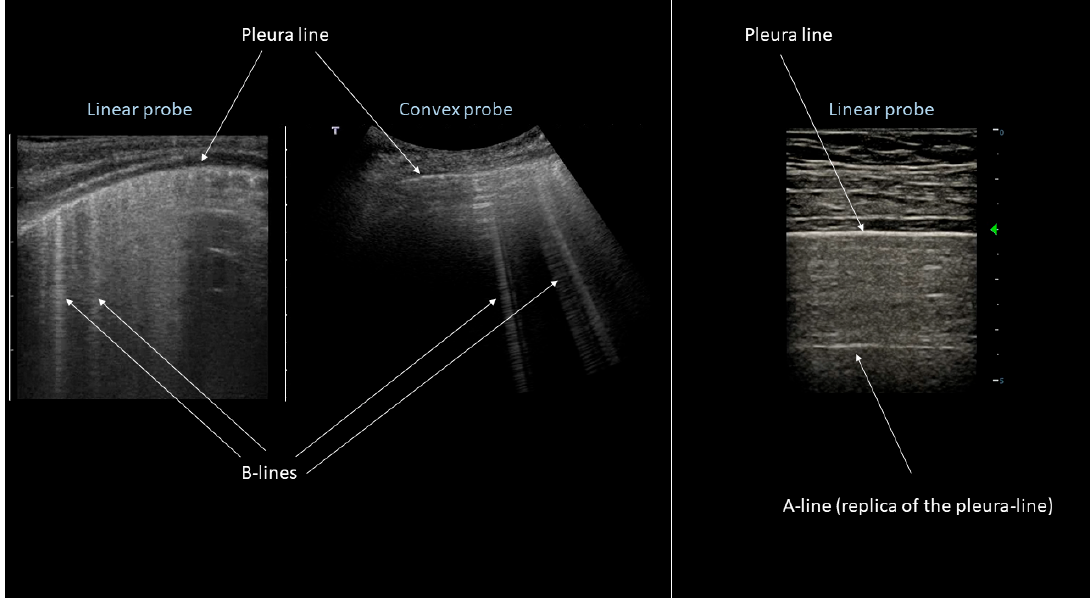
Figure 1. B-line artifacts as observable with a linear ( left ) and convex ( center ) probe and A-line artifact as observable with a linear probe ( right ). The pleura line is also indicated for the three images.